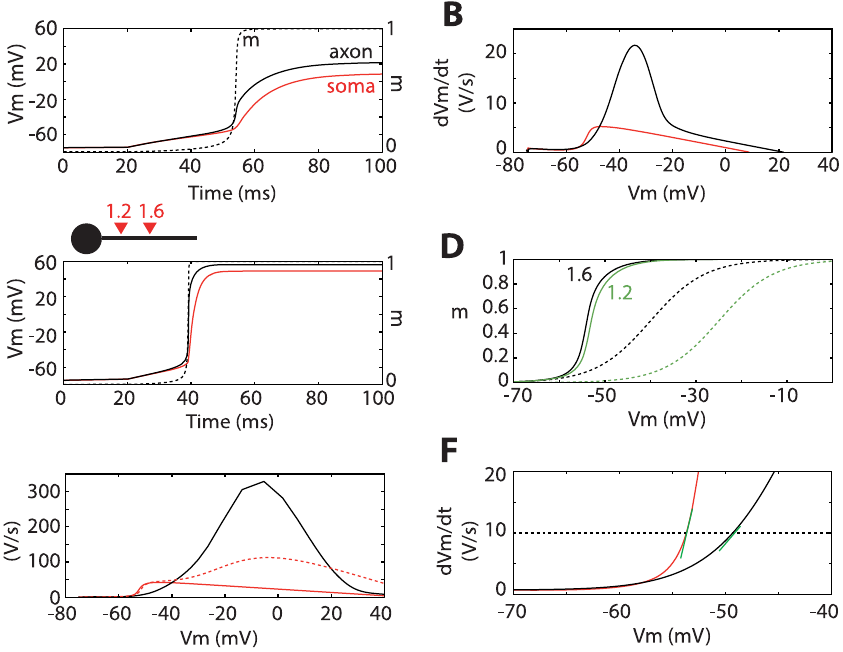
Figure 3. The ‘‘kink’’ at spike onset. A, A pulse of current is injected at time 20 ms at the soma. The spike is initiated in the axon (black), with Na channels opening almost all at once (dashed black: proportion of open channels), resulting in a discontinuity in the voltage derivative at the soma (the ‘‘kink’’). B, Phase plot (voltage derivative vs. voltage) at the initiation site (black) and at the soma (red), showing a (modest) kink at the soma of about 5 mV/ms. C, Same as A, but Nav1.2 channels are placed at 15 m m from the soma, in addition to the Nav1.6 channels at 40 m m. D, Proportion of open Na channels as a function of somatic voltage, for both channel subtypes (Nav1.6 at initiation site, Nav1.2 closer to the soma). The two activation curves are shown in dashed with the same colors. E, Same as B, but with the additional Nav1.2 channels. The dashed red curve shows the somatic phase plot when Nav1.2 channels are also added at the soma. F, Enlargement of panel F, Onset rapidness is measured as the slope of the trajectories (green segments) when dVm/dt reaches 10 mV/ms (dashed